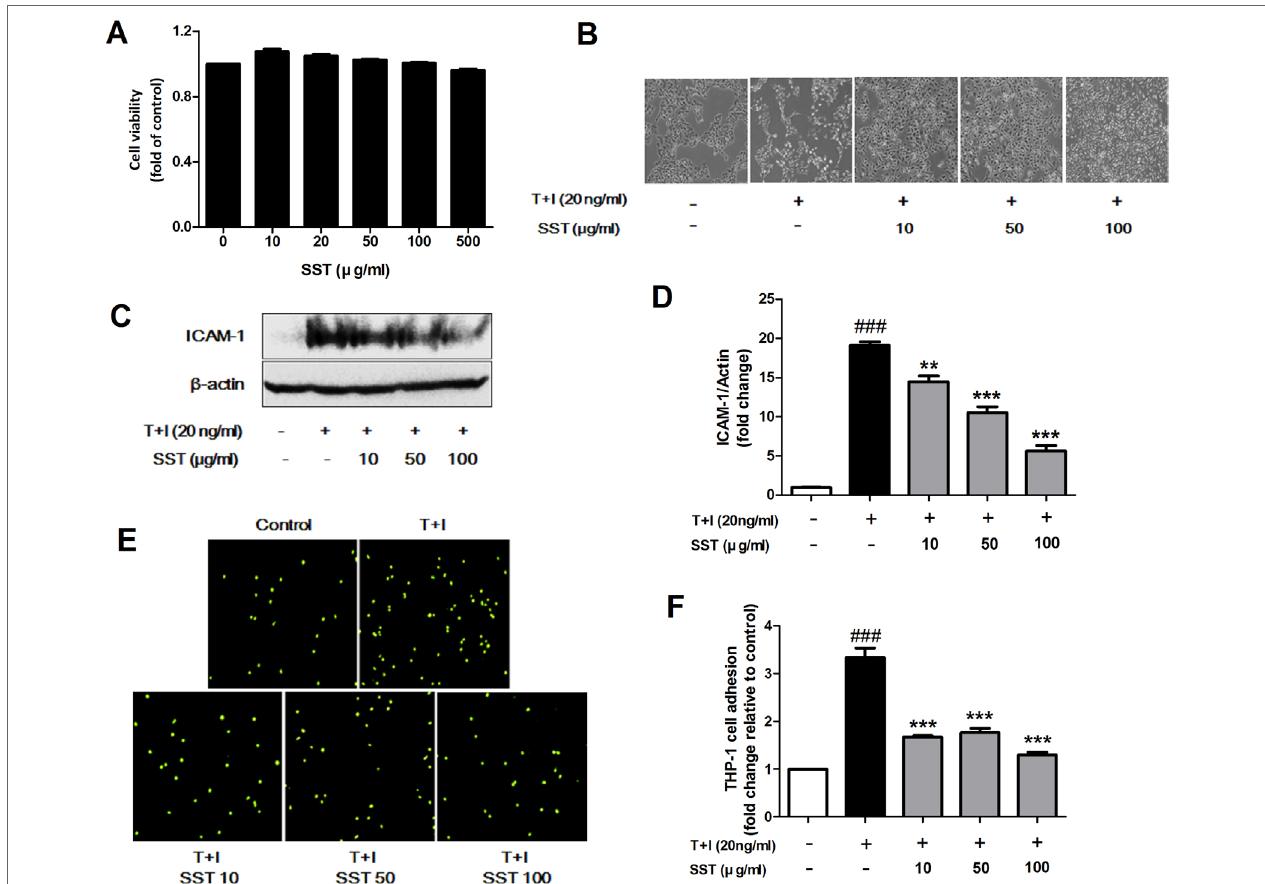
FIGURE 2 | Effects of SST on the tumor necrosis factor alpha (TNF- α )/IFN- γ -induced ICAM-1 expression and subsequent monocyte adhesion in HaCaT cells. Cell viability was analyzed using 3-(4,5-dimethylthiazole-2-yl)-2,5-biphenyl tetrazolium bromide (MTT) assay. Human keratinocyte (HaCaT) cells were incubated in the presence of SST at 10–500 μ g/ml or in the absence of SST [Dulbecco’s modified Eagle’s medium (DMEM) only] for 24 h (A) . Phase contrast images were taken to observe the morphological changes and proliferation of HaCaT cells due to TNF- α /IFN- γ stimulation and SST pretreatment (magnification: 100×) (B) . HaCaT cells were pretreated with various concentrations of SST for 30 min and treated with TNF- α /IFN- γ (20 ng/ml) for 24 h. The protein level of ICAM-1 was determined by western blot (C, D) . HaCaT cells were treated with SST and TNF- α /IFN- γ and co-cultured with fluorescent-labeled THP-1 cells at 37°C for 30 min. The adherent cells were counted. The graph is expressed as a fold change of the control (E, F) . The data are shown as mean ± SEM of triplicate experiment. ### p < 0.001 vs. no-treatment condition, **p < 0.01, ***p < 0.001 vs. only TNF- α /IFN- γ treatment